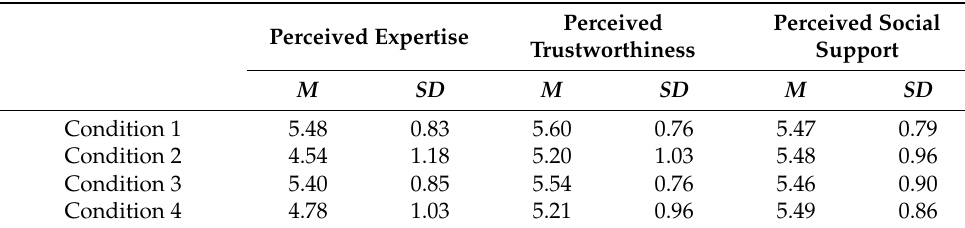
Table 3. Means and standard deviations. M —Mean; SD —Standard Deviation; Condition